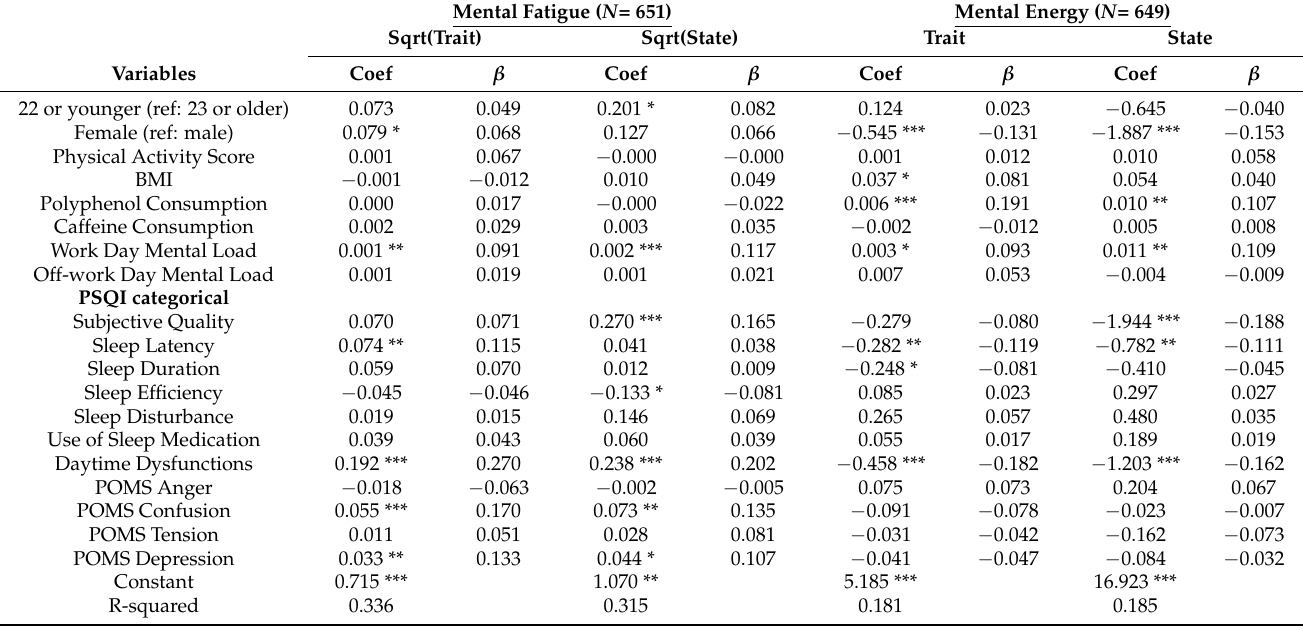
Table 4. Comparing predictors of trait and state mental energy and fatigue with PSQI being variables decomposed.